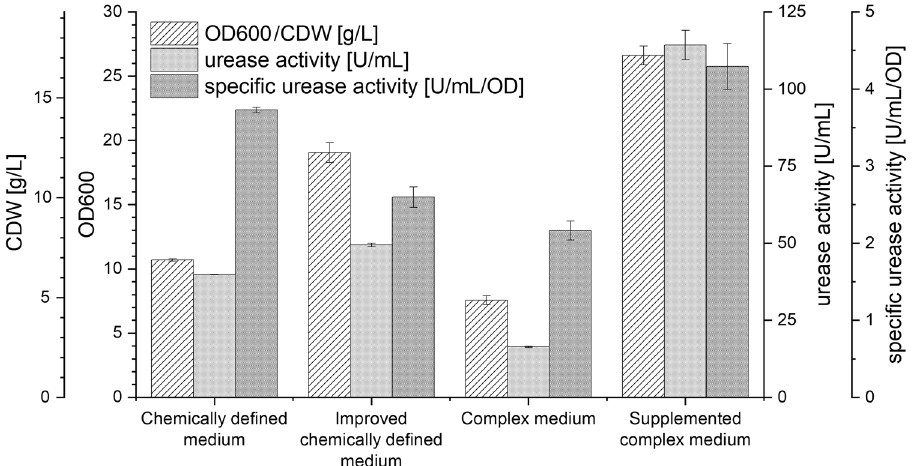
Figure 6. OD600, CDW, urease activity and specific urease activity of shake flask cultivations of S. pasteurii in different media, corresponding to the OTR and backscatter data in Fig. 5. CDW was calculated with a predetermined correlation from OD600 data. The chemically defined medium is described in Table 1. The improved chemically defined medium is supplemented with glutamate group amino acids. The complex medium corresponds to the YE medium. OTR and backscatter data from cultivation with the simple YE medium can be found in Supplementary Figure S11. The improved complex medium is supplemented YE medium with glucose, phosphate, trace elements, thiamine-HCl, nicotinic acid, L-methionine, L-cysteine and glutamate group amino acids, according to the concentrations of Table 1, based on the results of Fig. 4b (purple line). Here, arithmetic mean values derived from technical replicates (N = 3) are shown. The error bars depict the standard